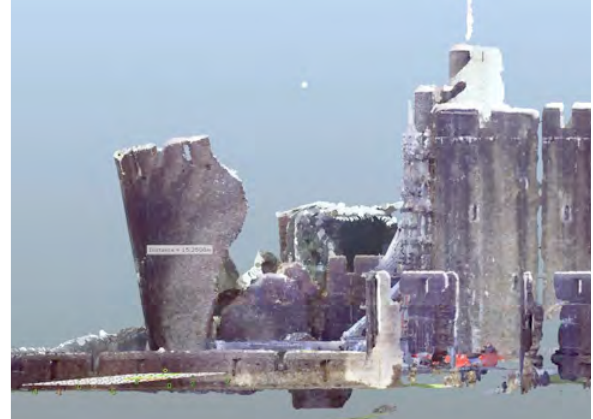
Figure 3. Elevation form laser